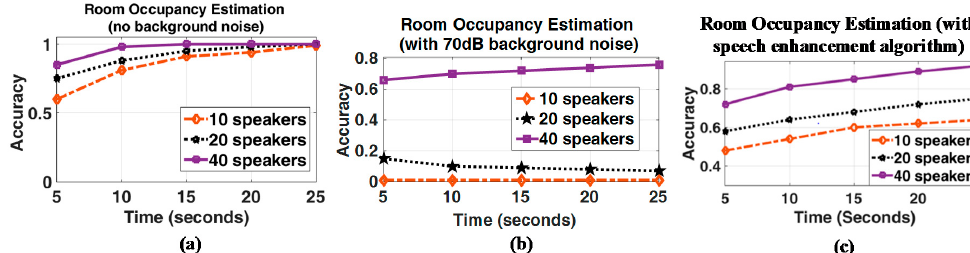
Figure 4. Speaker number estimation results assuming background sound is white Gaussian noise.